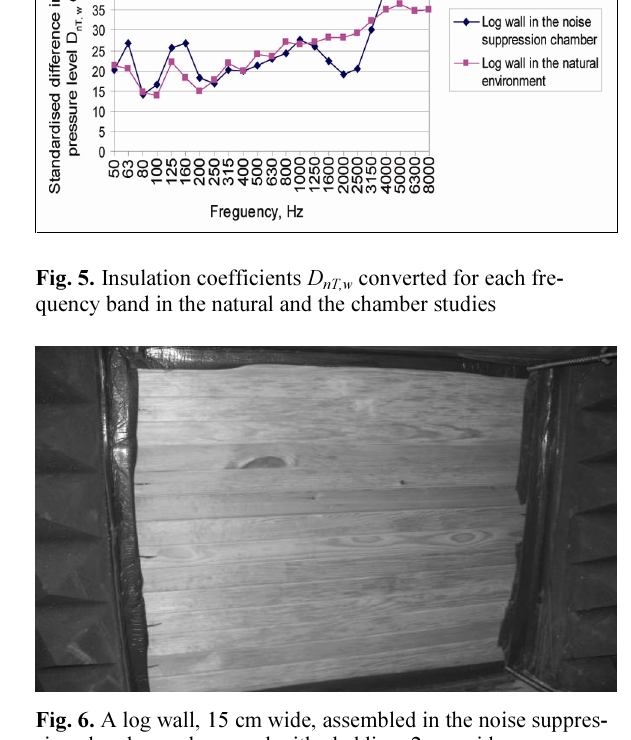
Fig. 6. A log wall, 15 cm wide, assembled in the noise